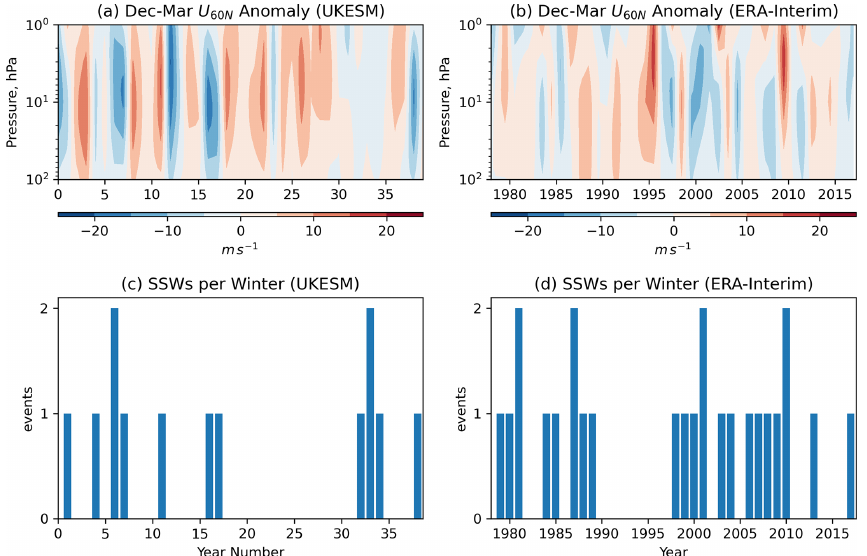
Figure 2. (a, b) December–March annual mean ZMZW anomaly from the climatological mean at 60 ◦ N from a 40-year sample from the pre- industrial control simulation of UKESM (a) and the ERA-Interim dataset between 1979 and 2018 (b) . (c, d) Time series of SSWs recorded per winter season in the same datasets.